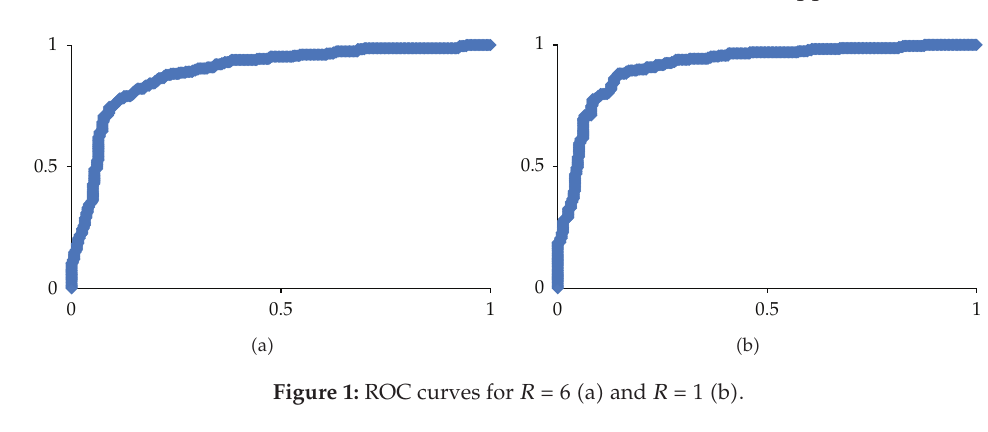
Figure 1: ROC curves for R (cid:8) 6 (cid:6) a (cid:7) and R (cid:8) 1 (cid:6) b (cid:7) .